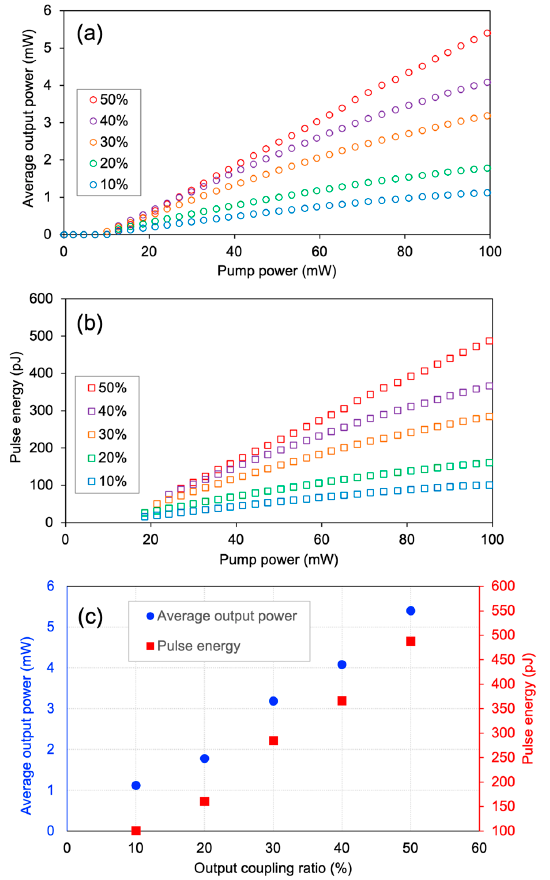
Figure 12. ( a ) Power and ( b ) energy development of EDFL with GNP-SA for different output coupling ratio values. ( c ) The value of output power and energy at the maximum pump power for different output coupling ratios.